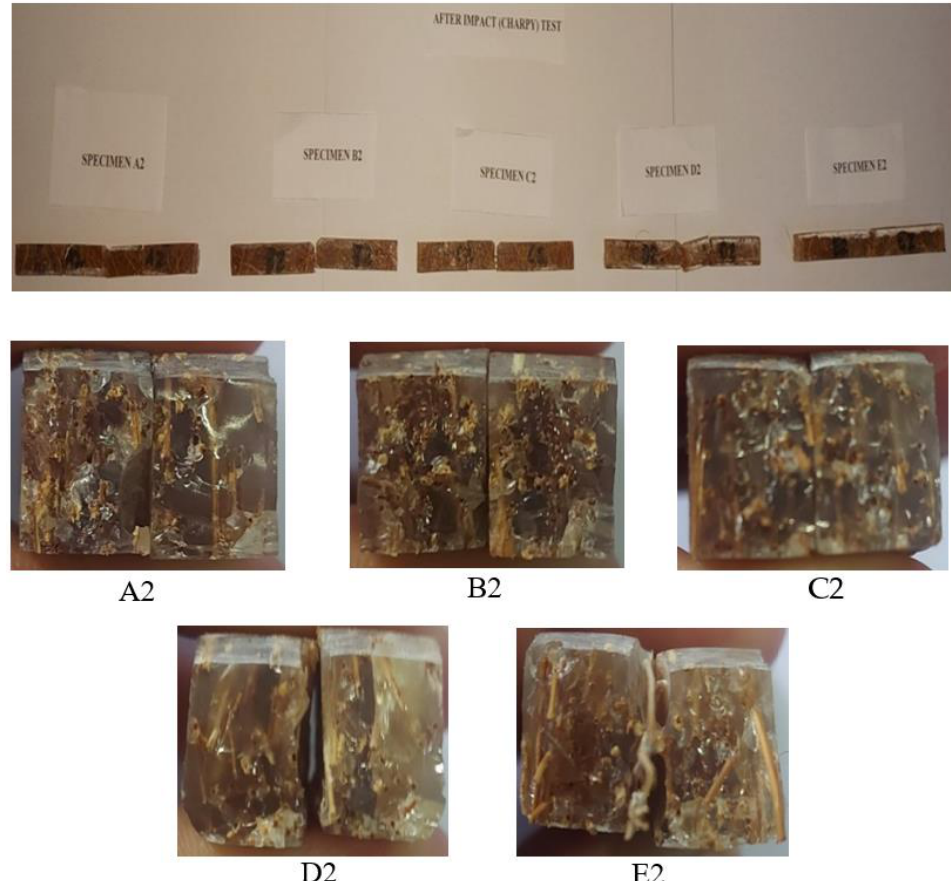
Figure 11. Variation in impact specimen failure of resin–catalyst matrix and sample cross-sectional images: ( A 2 ) 99.5%:0.5; ( B 2 ) 99%:1%; ( C 2 ) 98.5%:1.5%; ( D 2 ) 98%:2%; ( E 2 ) 97.5%:2.5%.